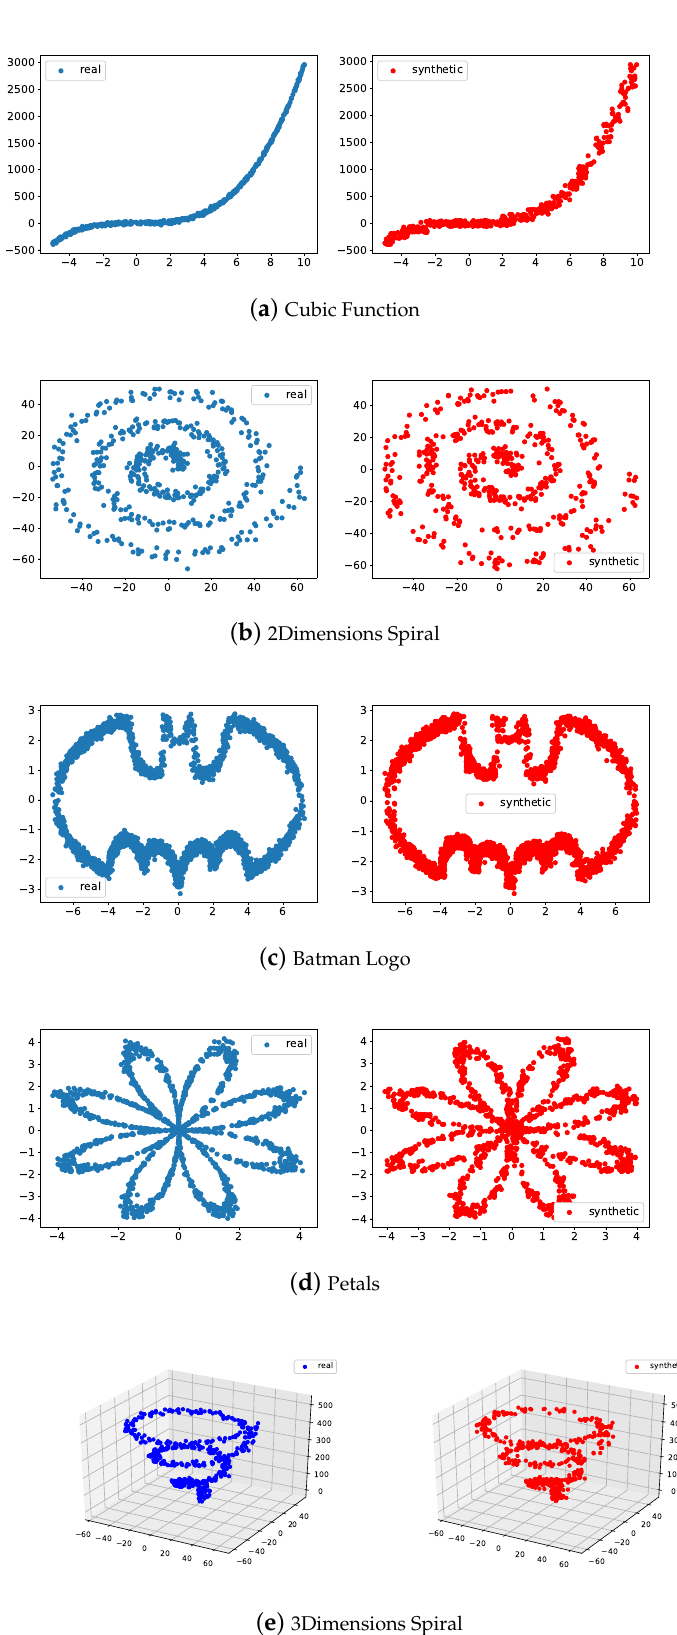
Figure 4. Scatter plots of the first group of